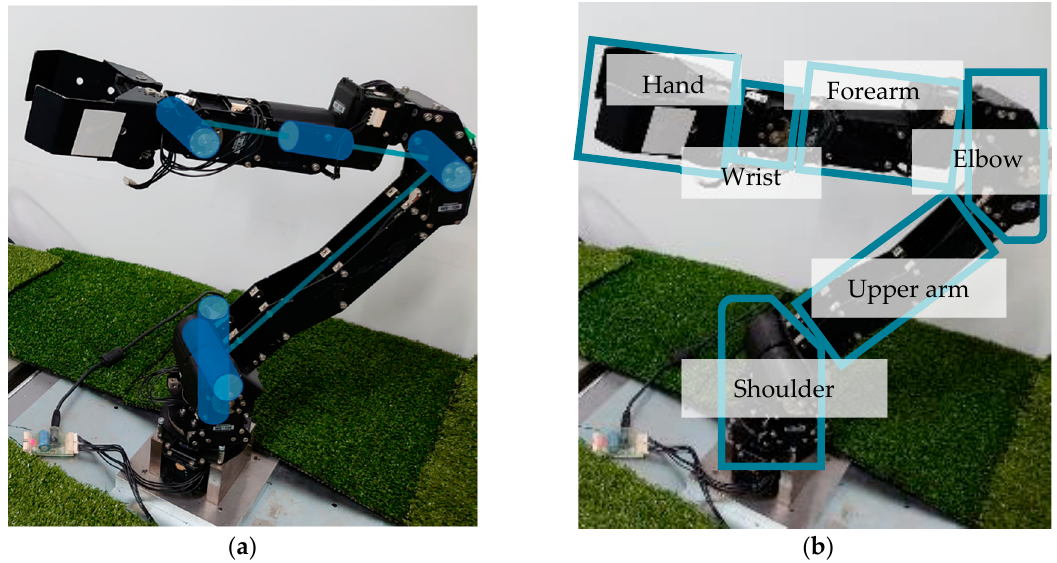
Figure 3. ( a ) Robot arm used for the experiment (body number is used in experiments), ( b ) robot arm part names.